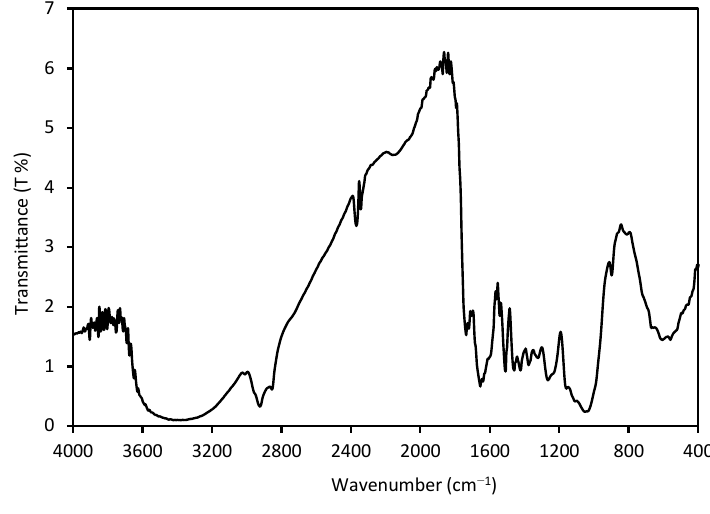
Fig. 1. FTIR spectrum of